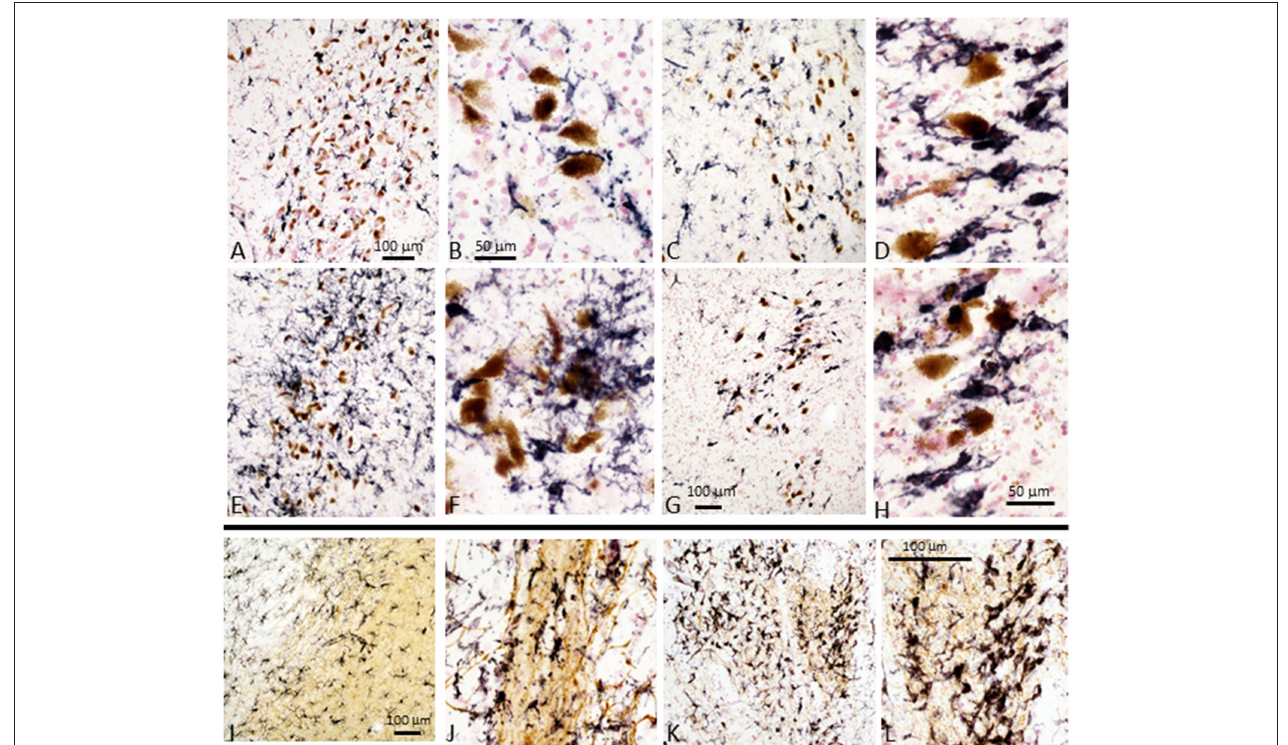
FIGURE 4 | Immunohistochemistry of microglia in tissue sections of SN and striatum. Substantia nigra: Immunohistochemical staining of sections from Control (A,B) , ILBD (C,D) , and PD (E,F) and PD (G,H) from SN tissue sections. (A,C,E,G) are lower magnification of SN tissue sections showing progressive increase in intensity of HLA-DR immunoreactive microglia (purple) from (A–E) , but PD case (G) showed reduced microglia intensity (burnt-out pathology) consistent with loss of SN neurons. Higher magnification images (B,D,F,H) illustrate the changes in morphology of microglia with progressive activation with reduction in burnt-out PD case. (H) shows microglia associated free neuromelanin. The preferential association of activated microglia with neuromelanin-containing dopaminergic neuron is apparent in all sections, even those from control cases. Striatum : Immunohistochemical staining of sections of Control (I,J) and PD (K,L) from striatum (putamen) stained with antibody LN3 to HLA-DR (purple) and tyrosine hydroxylase (brown). Control case (I,J) show association of microglia with tyrosine hydroxylase positive fibers. Stronger HLA-DR immunoreactivity (K) and activated morphology is apparent in association with remaining TH positive fibers in PD case (K,L) . Representative staining of sections from cases included in the antibody array series and are representative of each